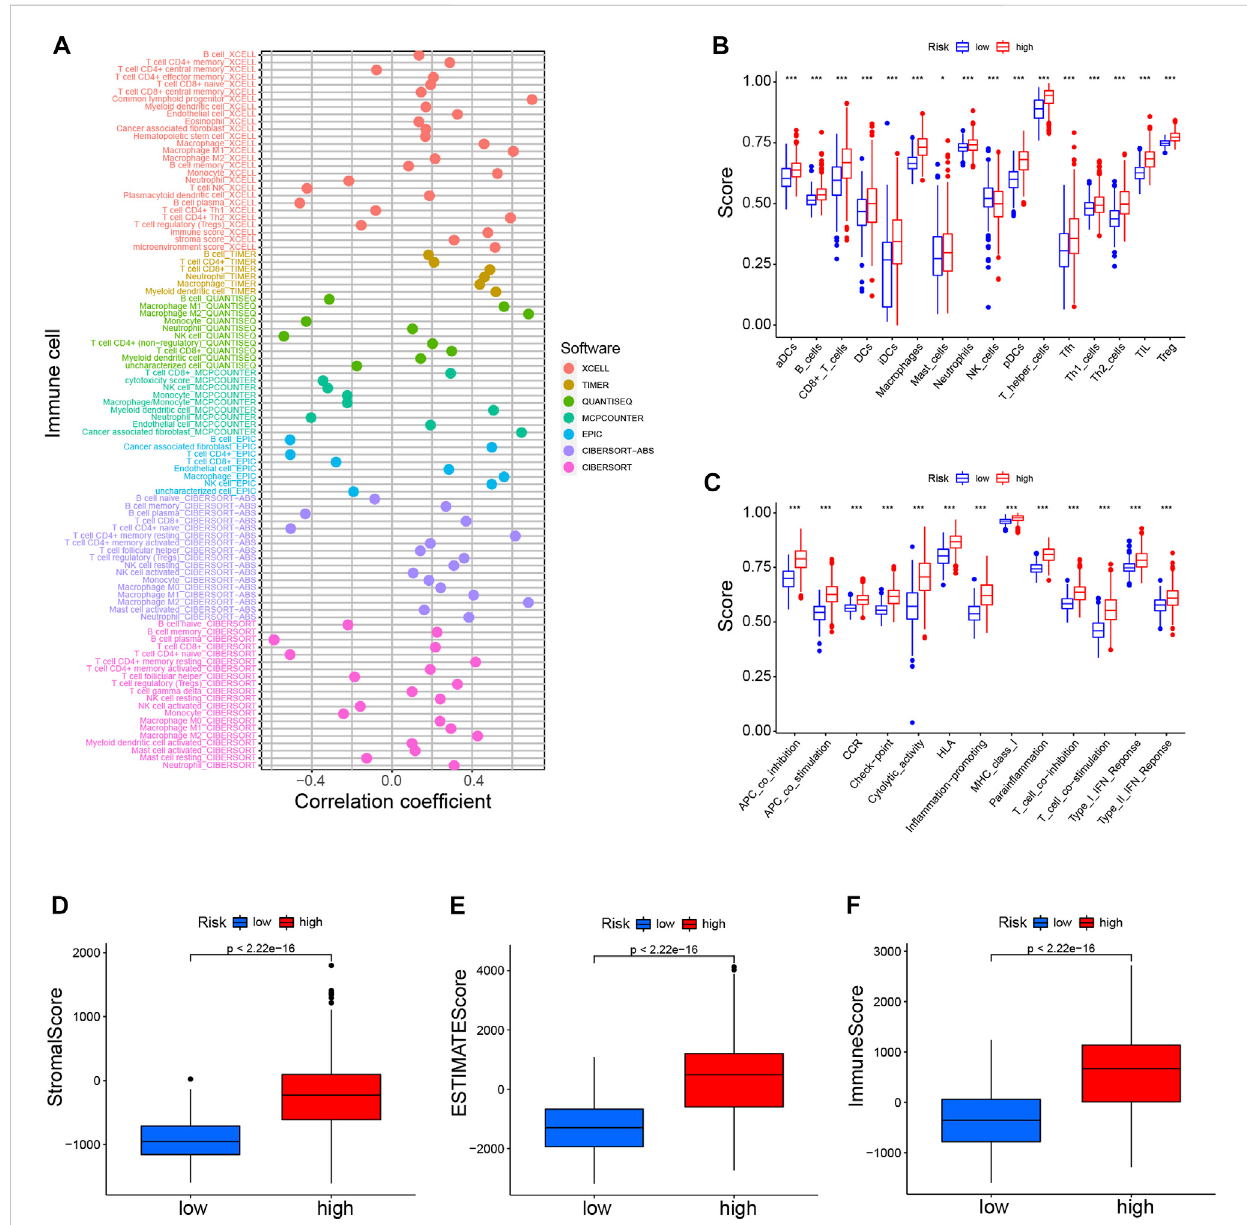
FIGURE 6 Immune landscapes of CRLs prognostic signature (A) . Heatmap for immune in fi ltration among high- and low-risk groups based on xCELL, TIMER, quanTIseq, MCP-counter, EPIC, CIBERSORT-ABS, and CIBERSORT algorithms (B) . SsGSEA analysis showing the extent of immune cell in fi ltrations in the high- and low-risk groups (C) . SsGSEA analysis displaying the functions of immune cell subpopulations between high-risk and low-risk groups (D – F) . Stromalscore,ESTIMATEscore,andimmunescoreinthehigh-andlow-riskgroups.* p < 0.05,** p < 0.01,*** p < 0.001.SsGSEA,single-samplegene set enrichment